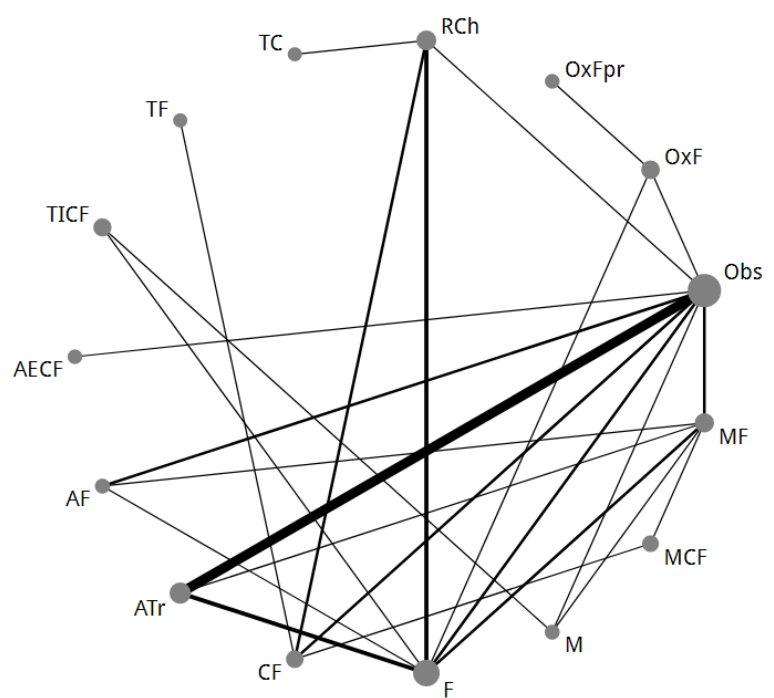
Figure 3. Second network of all different treatment regimens in the adjuvant therapy for curatively resected gastric cancer network meta-analysis (NMA-2). The size of each node corresponds to the number of patients who were randomly assigned to receive the given regimen. The lines connect the regimens that were directly compared in head-to-head randomized controlled trials (RCTs). The thickness of the lines corresponds to the number of RCTs. A = anthracycline; ATr = anthracycline-based triplet; C = cisplatin; E = etoposide; F = fluoropyrimidine; I = irinotecan; M = mitomycin C; Obs = observation; Ox = oxaliplatin; OxFpr = eight cycles of oxaliplatin-fluoropyrimidine thereafter eight cycles of fluoropyrimidine monotherapy; RCh = chemoradiotherapy; T =